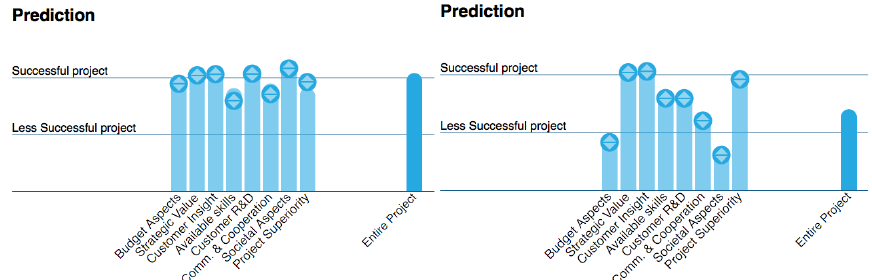
Fig. 4. Tool that helps users to explore which KPIs to improve on, with the largest effect on project success. (L) When users enter the tool, all scores are displayed as they were entered during the last project evaluation. Since the tool is based on an evaluation of the project portfolio of one organization, the significance of the elements will differ per company, meaning that each organization has its own version of the SEM-model in Figure 3. (R) When users play with the slider bars, the other values are also affected. E.g. in this case, the societal aspects KPI is lowered (e.g. hypothetically due to the fact that the innovation is apparently less eco-friendly as was initially anticipated). According to the SEM-model (Figure 3), hereby also other KPIs are affected, lowering their scores as well, along with the entire success chance of the project. This shows it is apparently important (in this dummy-model) to safeguard the value of societal